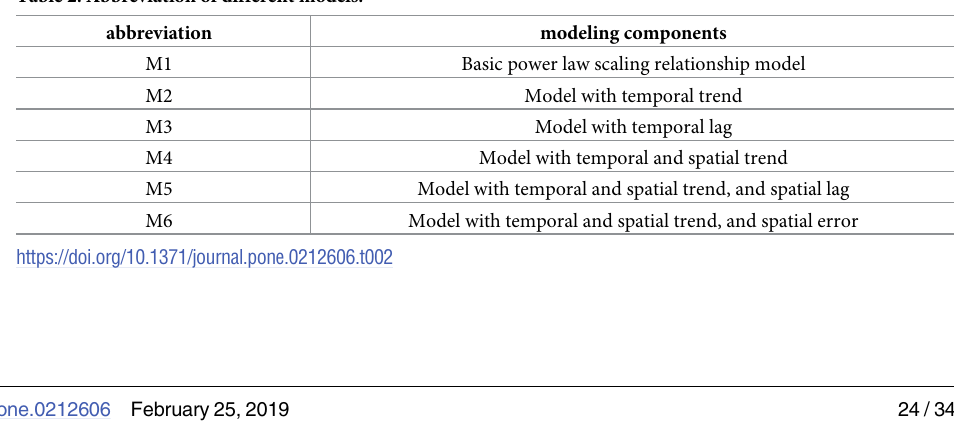
Table 2. Abbreviation of different